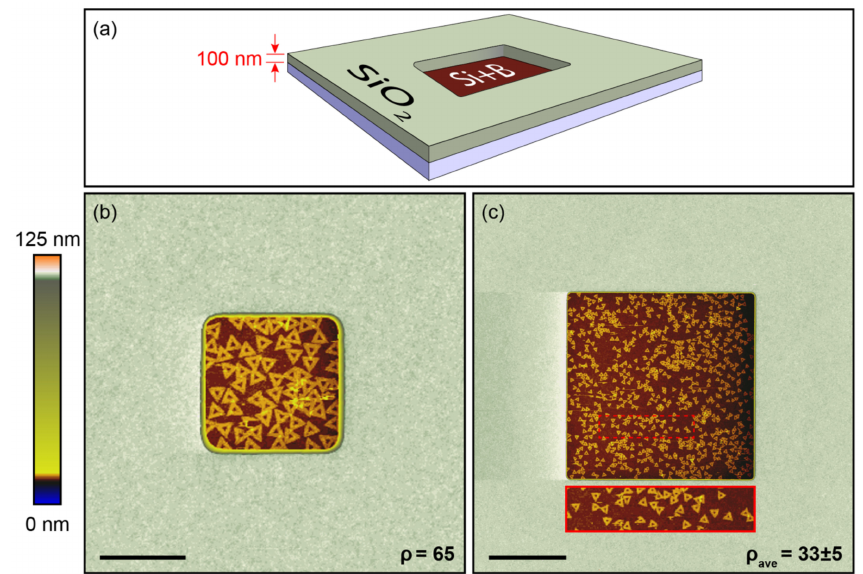
Figure 4. Schematic of a boron-implanted silicon feature surrounded by 100 nm thick SiO 2 ( a ). AFM height images of lithographically fabricated 1 µ m × 1 µ m ( b ) and 5 µ m × 5 µ m ( c ) boron-implanted silicon features surrounded with SiO 2 . The z-axis color scale was adjusted to show nanometer-scale contrast both within the well and on SiO 2 (100 nm above the well). The deposition buffer was 10 mM bis-tris HCl, with a pH of 6.6, and a [MgCl 2 ] of 35 mM. DNA origami triangles adsorbed with a surface density of 65/ µ m 2 in ( b ) and 33 ± 5/ µ m 2 in ( c ) on the boron-implanted silicon surfaces, while no DNA origami adsorbed onto the SiO 2 surfaces. The rectangular insert is a 2 × magnified image of the boron-implanted silicon surface shown in ( c ). For both samples, the deposition incubation time was ~1 h. Scale bars are 600 nm for ( b ) and 2 µ m for ( c